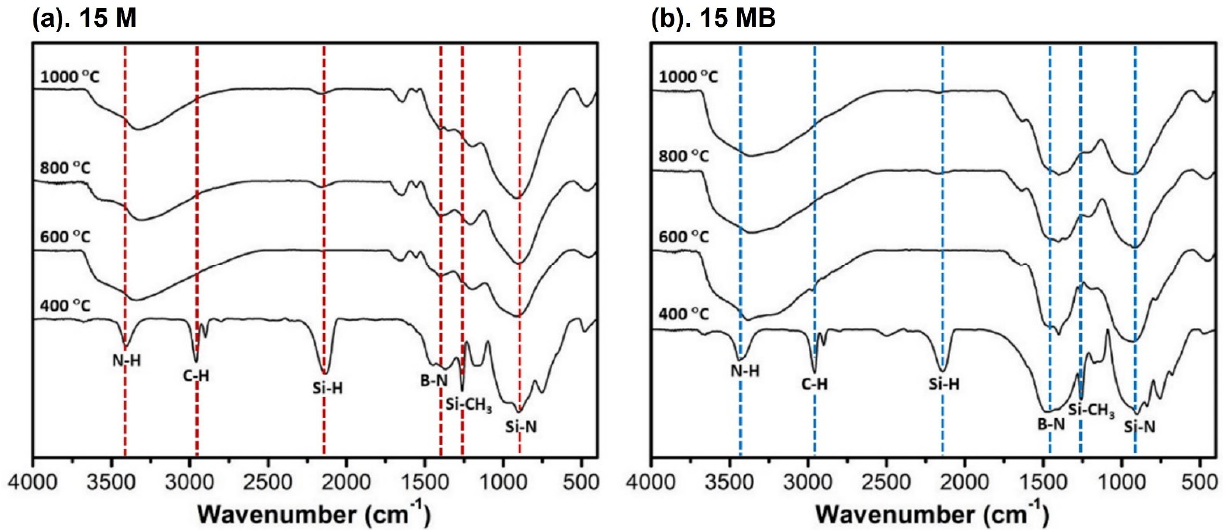
Figure 5. FTIR spectra of the pyrolysis products of ( a )15 M and ( b )15 MB at different temperatures.